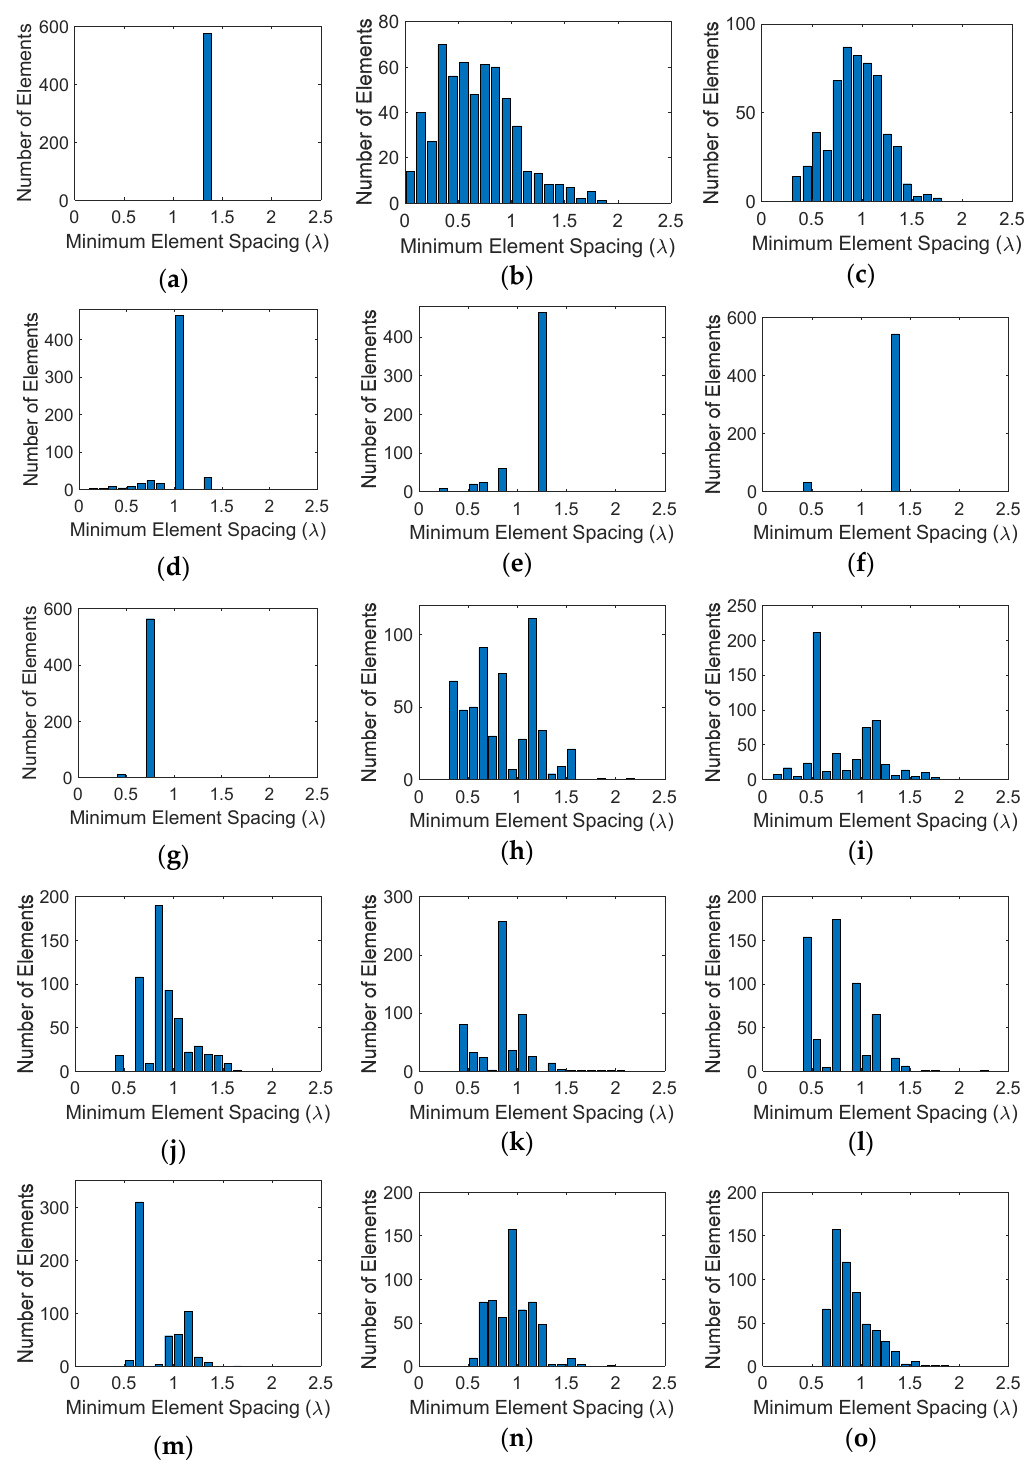
Figure 4. Bar plot of minimum element spacings with different distributions: ( a ) uniform, ( b ) random, ( c ) random with jitter, ( d ) Hammersley (base 2), ( e ) Hammersley (base 3), ( f ) Hammersley (base 5), ( g ) Hammersley (base 7), ( h ) Halton (bases 2, 3), ( i ) Halton (bases 2, 5), ( j ) Halton (bases 2, 7), ( k ) Halton (bases 3, 5), ( l ) Halton (bases 3, 7), ( m ) Halton (bases 5, 7), ( n ) Sobol, ( o ) Poisson disk.